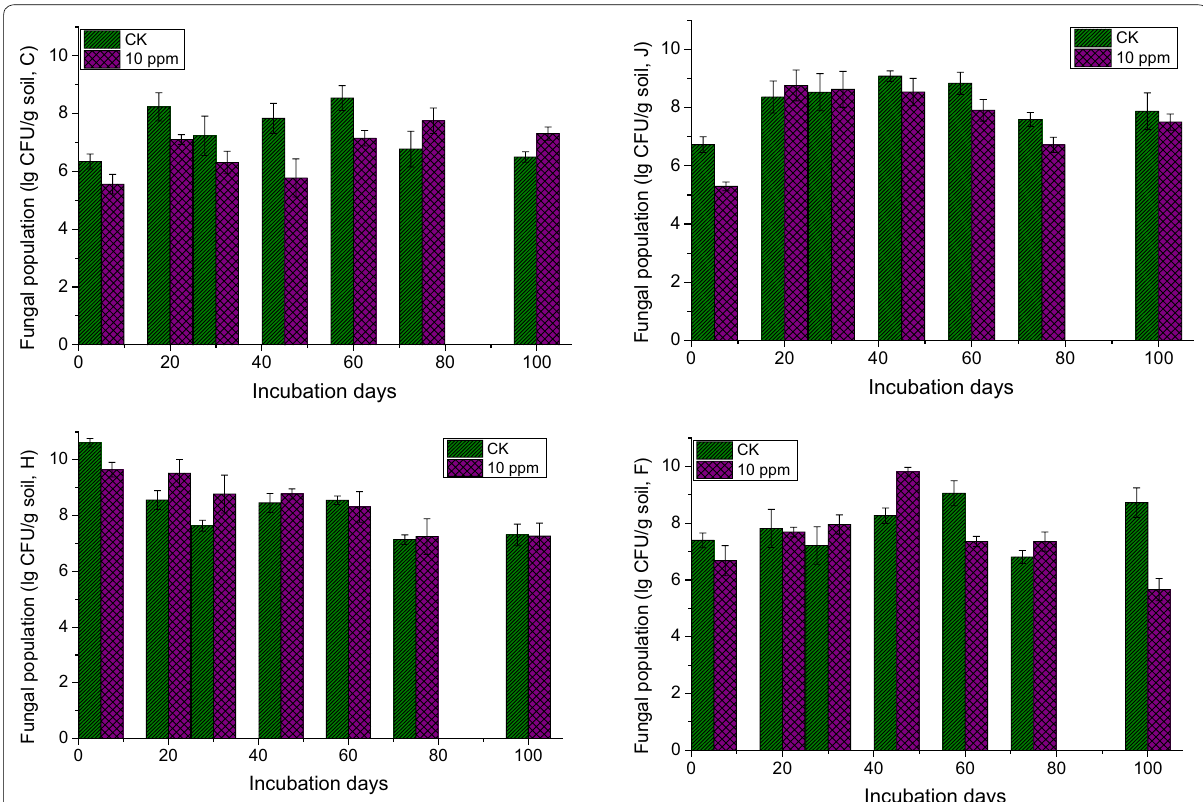
Fig. 1 Effect of IPP on soil fungal population for different incubation periods in